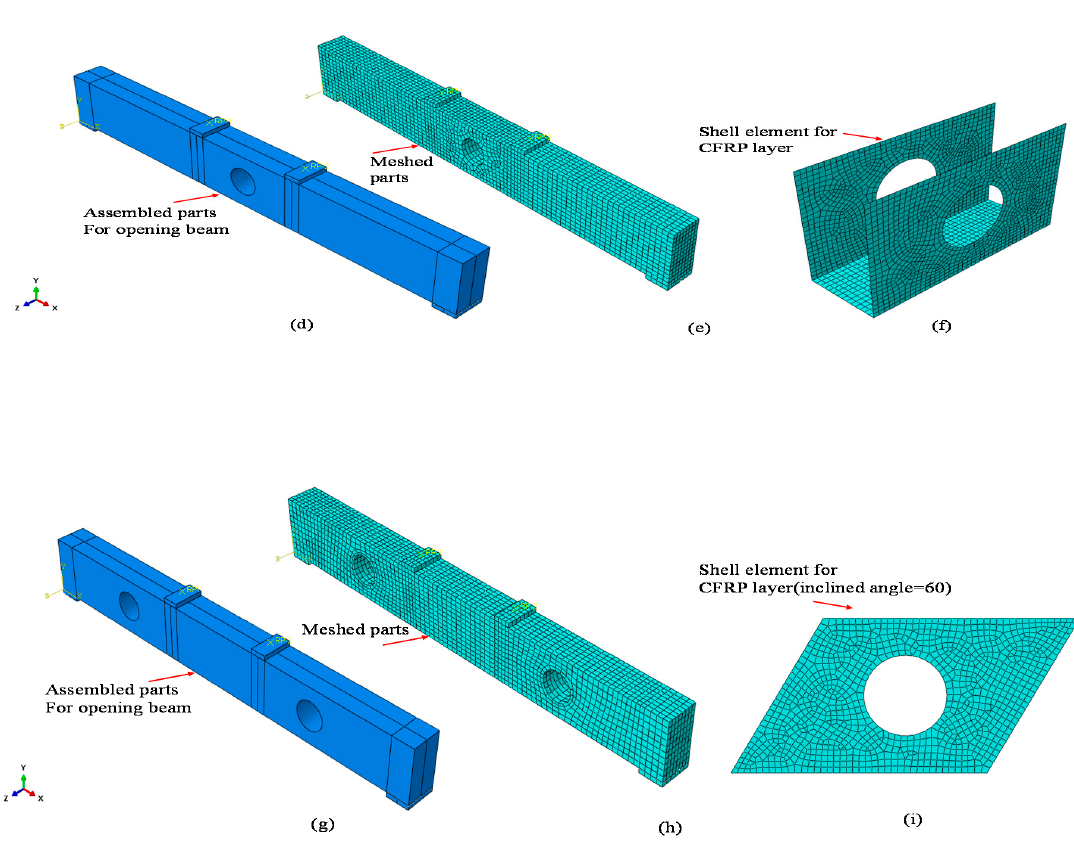
Figure 12. Finite element (FE) models for 3D specimens: ( a ) assembled beam element B-0, ( b ) steel rebars for beam B-0; ( c ) mesh element for B-0, ( d ) opening beam in the flexural zone BC-1, ( e ) mesh elements for BC-1, ( f ) two layers of CFRP for beams BC-3 and BC-5, ( g ) opening beam in the shear zone BC-2, ( h ) mesh element for BC-2, ( i ) two layers of inclined CFRP for beams BC-4 and BC-6.